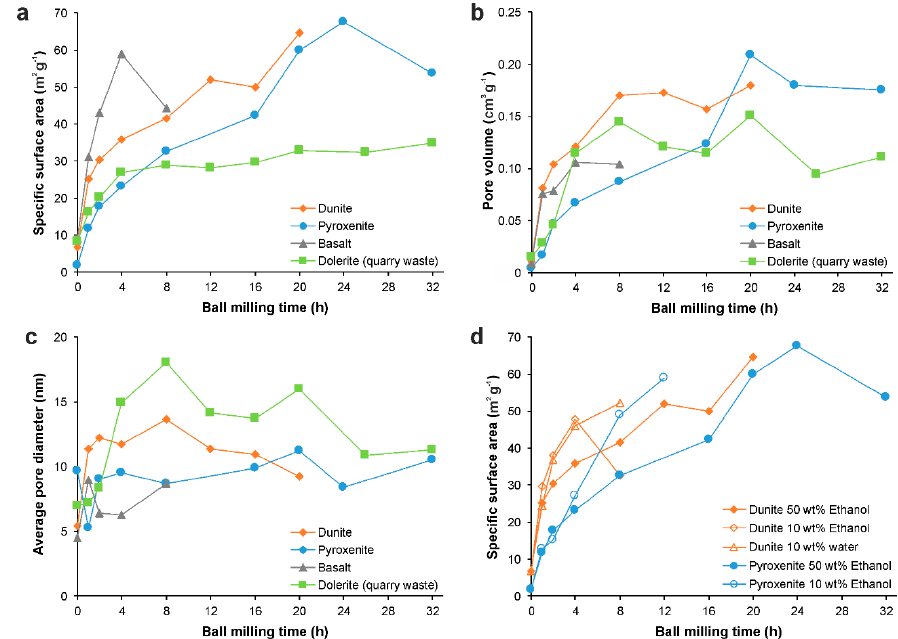
Figure 3. ( a ) BET (m 2 g − 1 ) specific surface area, ( b ) pore volume (cm 3 g − 1 ) and ( c ) average pore diameter (nm) plotted versus the ball milling time (h), for the milled rocks acquired after ball milling with 50 wt% ethanol. ( d ) BET (m 2 g − 1 ) specific surface area plotted versus the ball milling time (h), for the dunite and pyroxenite samples acquired after milling with different types and quantities of PCA (data from Rigopoulos et al.